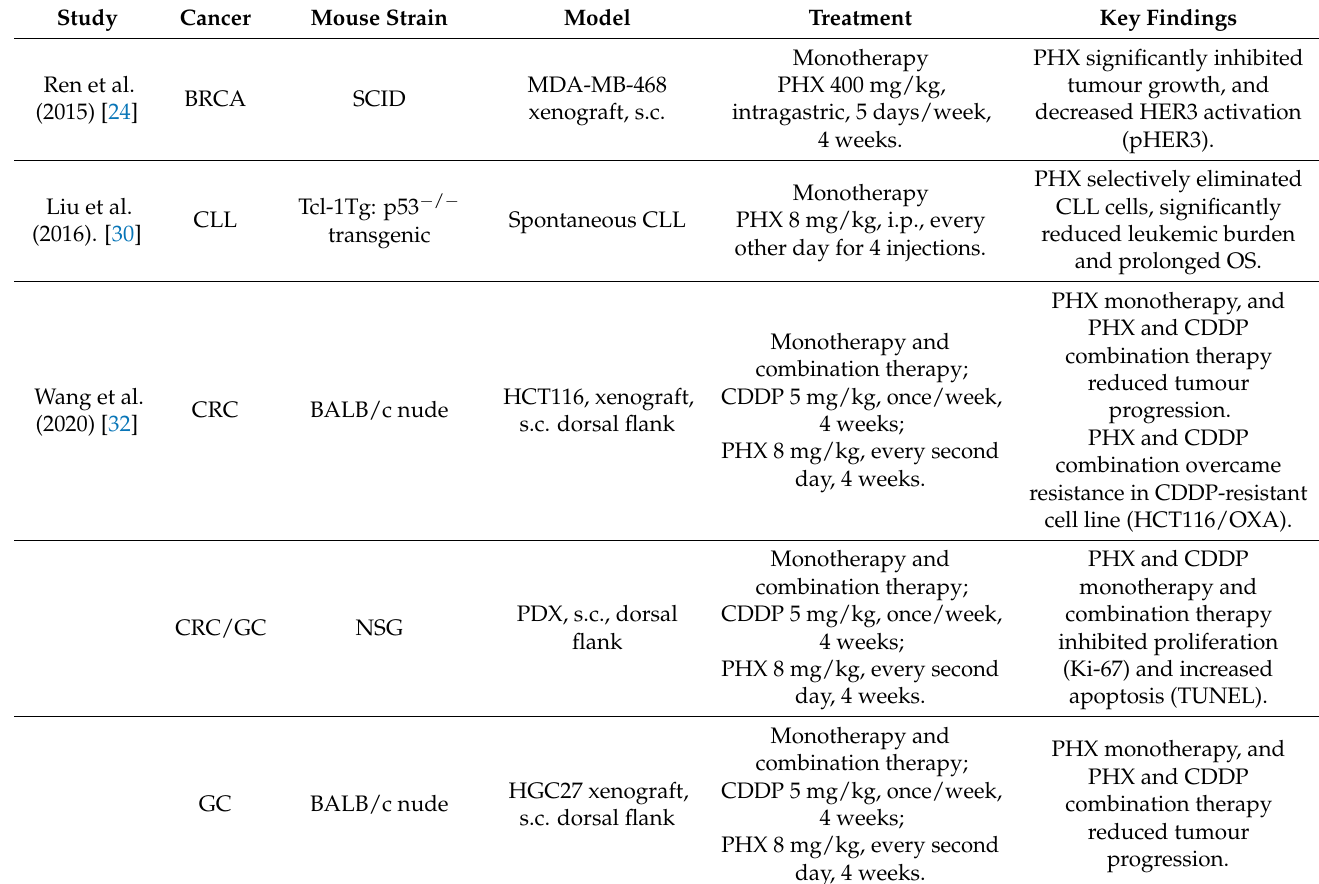
Table 2. Effects of perhexiline treatment in preclinical murine cancer